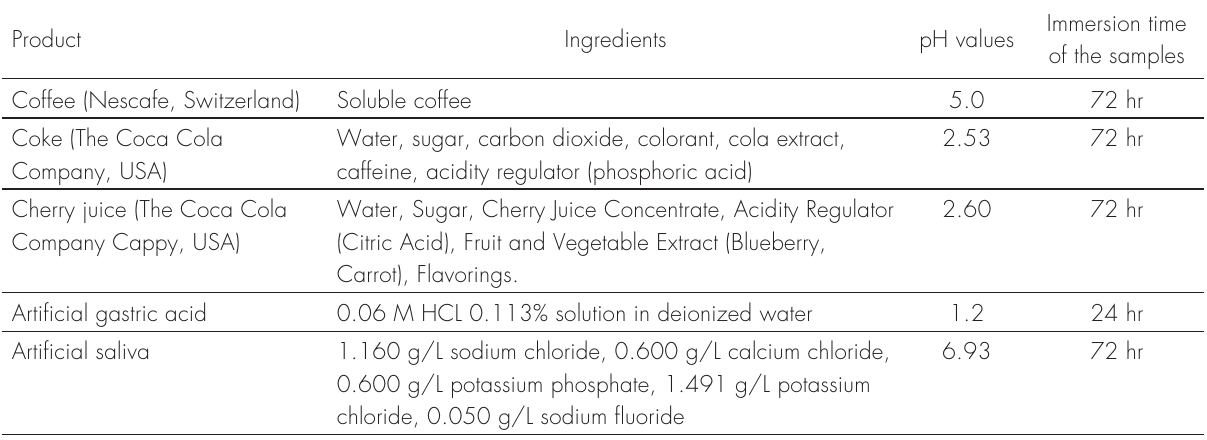
Table II. Liquids-related